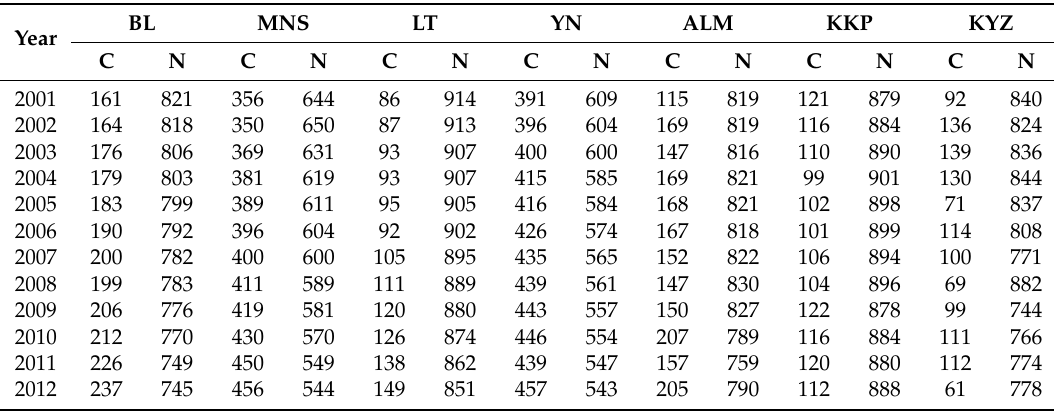
Table 4. Number of randomly selected validation samples (pixels) between 2001 and 2016 for cropland (C) and non-cropland (N) in seven test